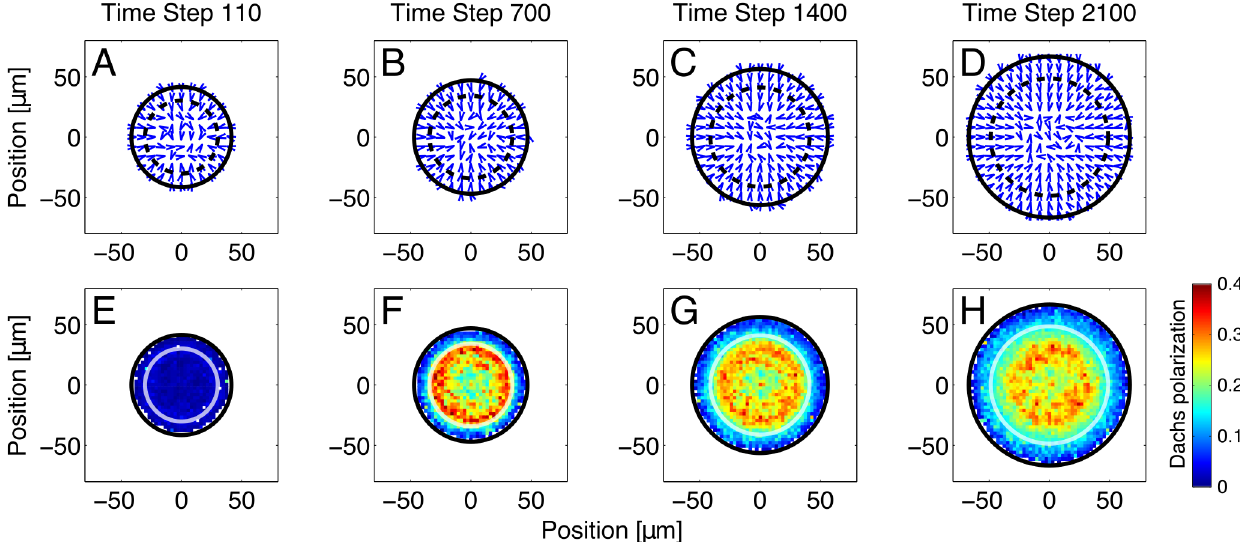
Fig 5. The annulus of Dachs polarization produced by a stationary Ds expression front. Again, the direction(panels A-D) and magnitude (panels E-H) of Dachs localizationin the disc in a singlerun are pictured. Dachs localization was a vector whose magnitude varies from zero, for an isotropic distribution of Dachs, to unity, if Dachs was all on one side. More details on simulatedDachs localizationare given in Section 6 of the Supplemental Text. The arrows in panelsA-D represent spatialaveragesof the directionof Dachs localization; panels E-H show the magnitude of Dachs polarization. Blue represents less asymmetry, red represents more. Images are taken at 110 (A and E), 700 (B and F), 1400 (C and G), and 2100 (D and H) minutes into the third instar. Because the same set of cells was near the Ds expressionfront (black dashed circle in panels A-D, white circle in panelsE-H) throughoutthe run of the simulation, this set of cells experienced elevatedDachs localization (red ring in panels E-H). Dachs localization near the front pointedpredominantlyinward due to the steep local slope of Ds, and was weaker and less directed near the disc’s center and edge, far from the front (green/bluemarkers in panelsE-H). The Dachs polarizationin these regions away from the front was primarily due to the Fj gradient. (S15 Fig in the SupportingInformation shows similarlyweak polarization when Ds is uniformly expressed.)